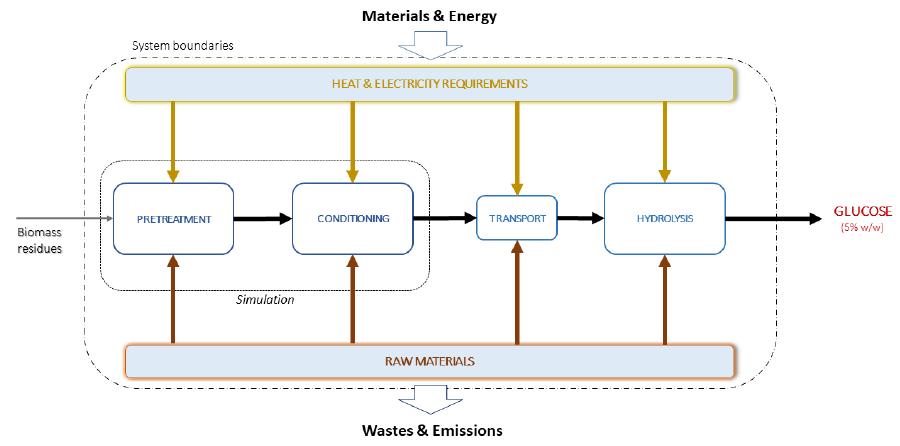
Figure 1. System boundaries for the maize starch based process (MS-bp).